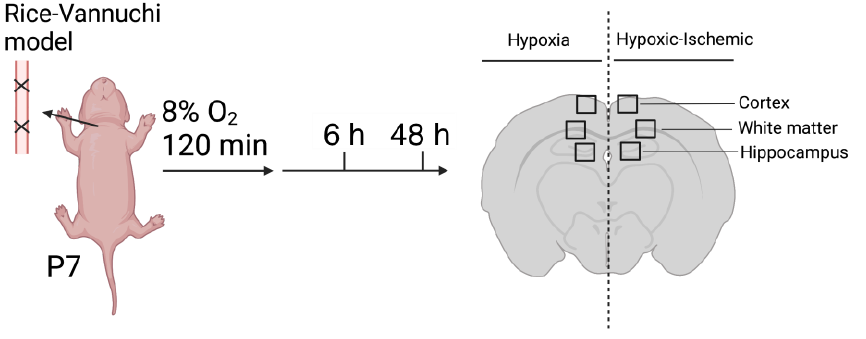
Figure 5. Schema of experimental design.